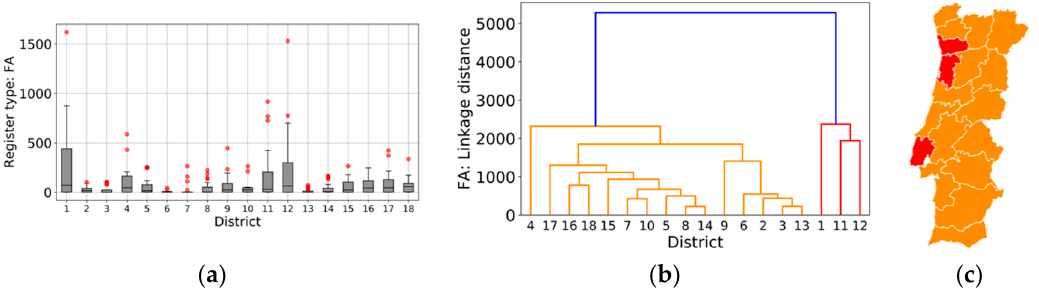
Figure 5. Spatial distribution of Total forest fires with burned area less than 1 ha (A): ( a ) Distribution by district; ( b ) Clusters by annual profile of distribution; ( c ) Clusters in geographical location (cophenetic coefficient: 0.94).